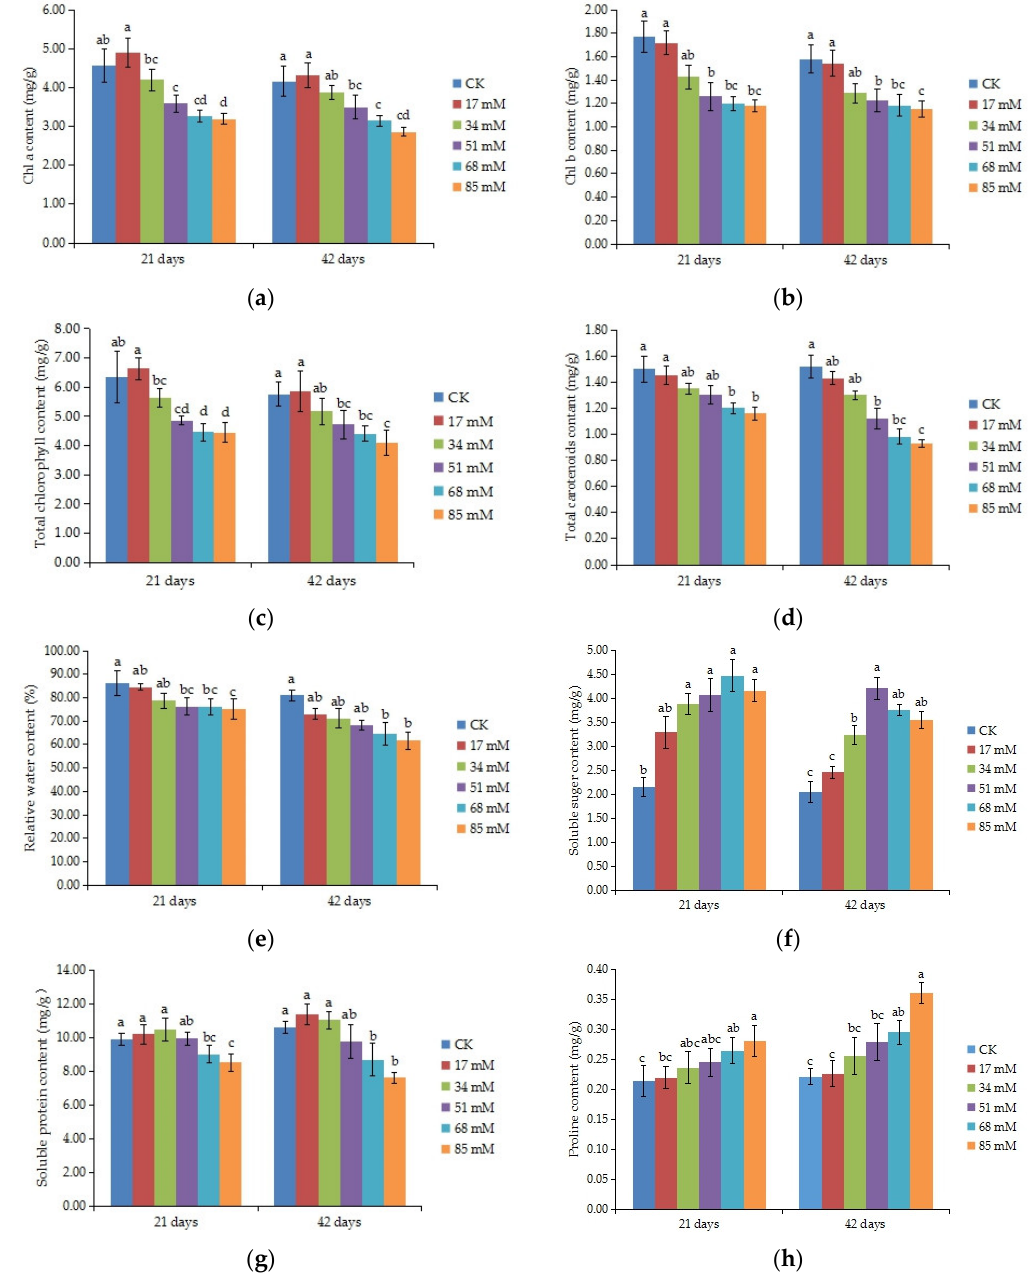
Figure 2. Effect of increasing levels of soil salinity on the content of chlorophyll a ( a ), chlorophyll b ( b ), total chlorophyll ( c ), and total carotenoids ( d ), relative water content ( e ), soluble sugars ( f ), soluble proteins ( g ), and proline content ( h ) in leaves of C. turczaninowii plants grown for 21 and 42 days. Different lowercase letters indicate significant differences among treatments ( p < 0.05), n = 3.